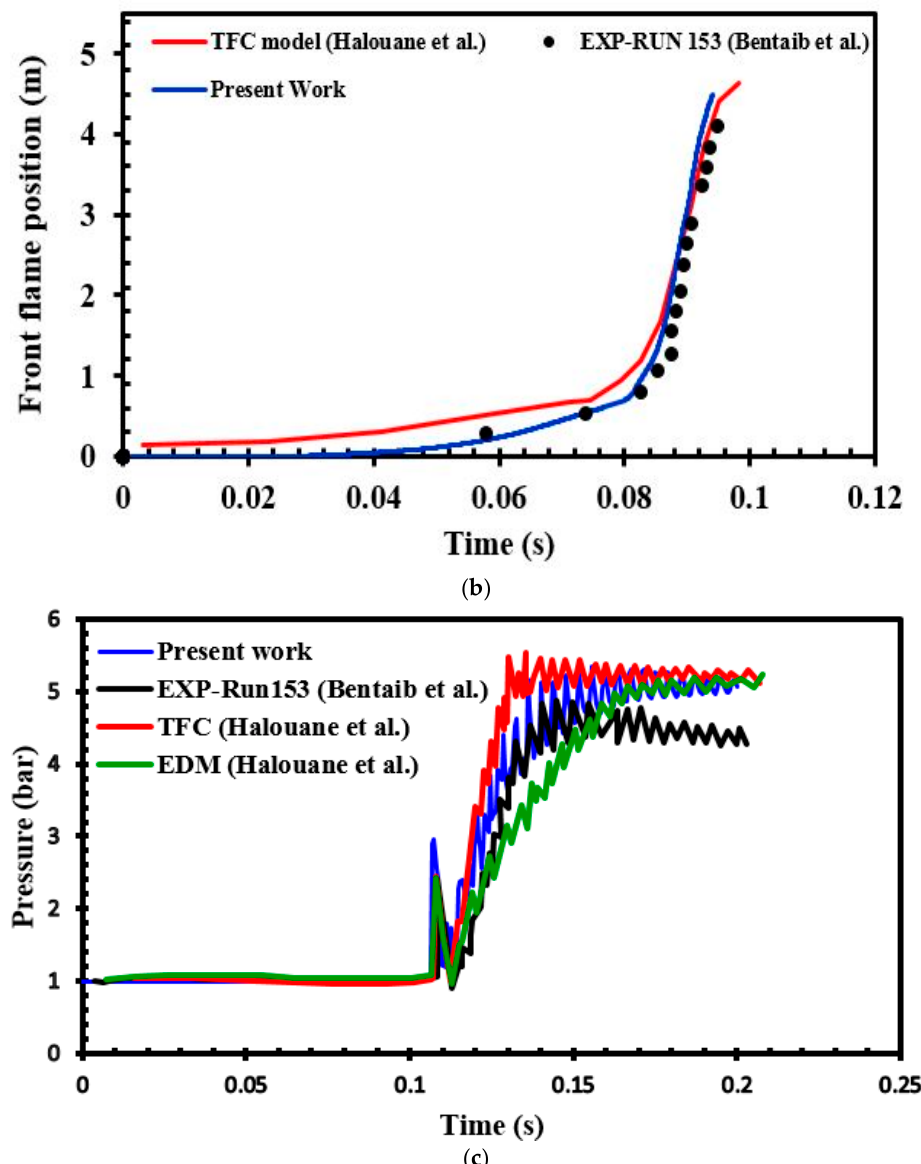
Figure 5. ( a ) The flame velocity in H 2 –air mixture with 13% hydrogen concentration, along with the experimental results of Bentaib et al. [17] and the numerical results of Halouane et al. [39]; ( b ) The front flame position in the mixture with 13% hydrogen concentration, along with the experimental results of Bentaib et al. [17] and the numerical results of Halouane et al. [39]; ( c ) The channel pressure history recorded at elevation 2.877 m in the mixture with 13% hydrogen concentration, along with the experimental results of Bentaib et al. [17] and the numerical results of Halouane et al. [39] . Based on the results presented in Figure 5a, there is a suitable agreement between the experimental and numerical results, and, therefore, the current solver could reproduce properties such as laminar and turbulent flame velocities for the hydrogen–air mixture.